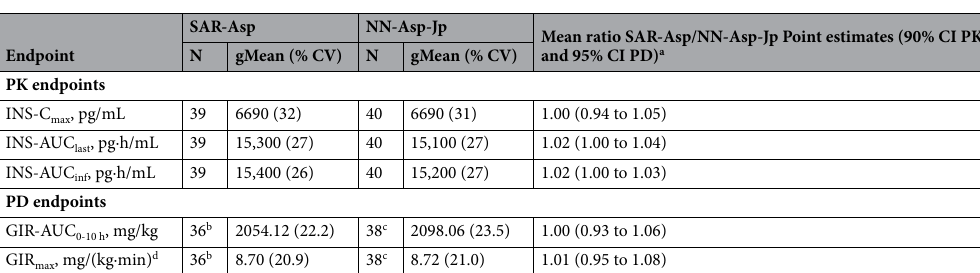
Pharmacodynamics. In the pharmacodynamic analysis, the mean smoothed bodyweight normalized GIR profiles during the euglycemic clamp procedure (from time 0 to 10 h postdose) were nearly superimposable for SAR-Asp and NN-Asp-Jp (Fig. 1B). The overall pharmacodynamic effects of both treatments were similar, displaying a short time-action profile. The extent of glucose-lowering, indicated by gMean GIR-AUC 0–10 h and GIR max values, was similar for SAR- Asp and NN-Asp-Jp (Table 2), with the gMean ratios close to 1 and the corresponding 95% CIs for each param- eter entirely within the equivalence interval (0.80–1.25). This confirmed equipotency of the two treatments. Between-subject variability for GIR-AUC 0–10 h and GIR max was low, as shown by CVs between 21 and 24%. The median GIR-t max for SAR-Asp (2.82 h) was similar to that for NN-Asp-Jp (2.35 h). Performance of the clamp. Several parameters were used to assess clamp quality during euglycemia (Table 3). Individual mean blood glucose levels were similar for both treatments (mean values of 79.51 and 79.89 mg/dL for SAR-Asp and NN-Asp-Jp, respectively). Individual variability of blood glucose measurements was low with median CV% values of 7.05% and 5.90% for SAR-Asp and NN-Asp-Jp, respectively. Similarly, absolute differences between individual mean blood glucose measurements and the blood glucose target level were low (mean of 2.31 mg/dL for SAR-Asp and 1.74 mg/dL for NN-Asp-Jp).